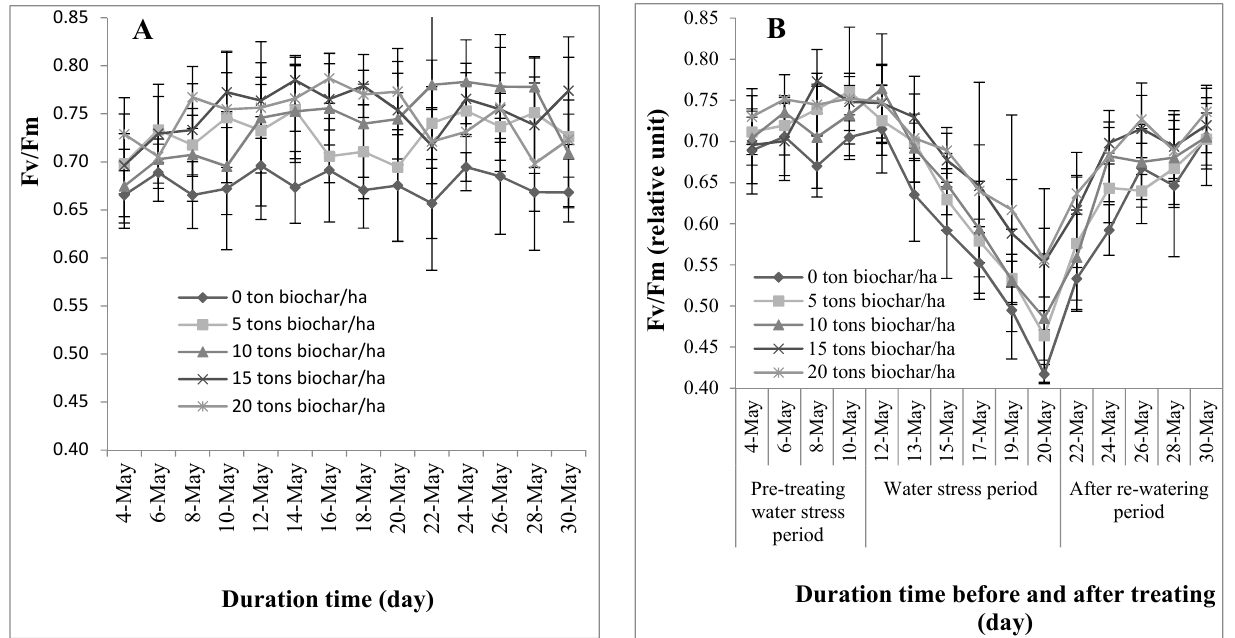
Figure 3. Effect of biochar on F v /F m of Ehretia asperula under the non-WSC ( A ) and WSC ( B ). Vertical bars represent the mean ± SD, n = 15.